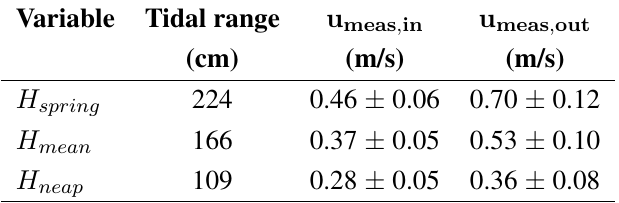
Table 7. Comparing the measured velocity, u and neap tide. Index in is incoming velocity (flood) and out is outgoing velocity (ebb). Only maximum values have been